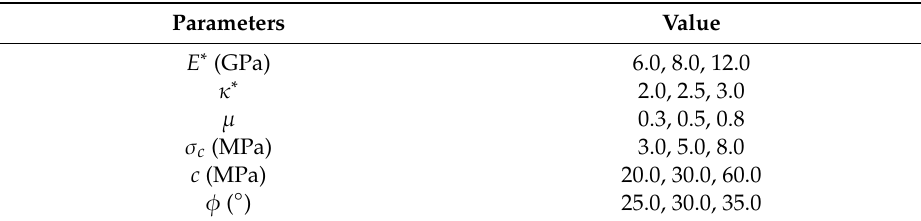
Table 2. Tested values of micromechanical parameters. Tabl e 2 . Tested values of micromechanical parameters